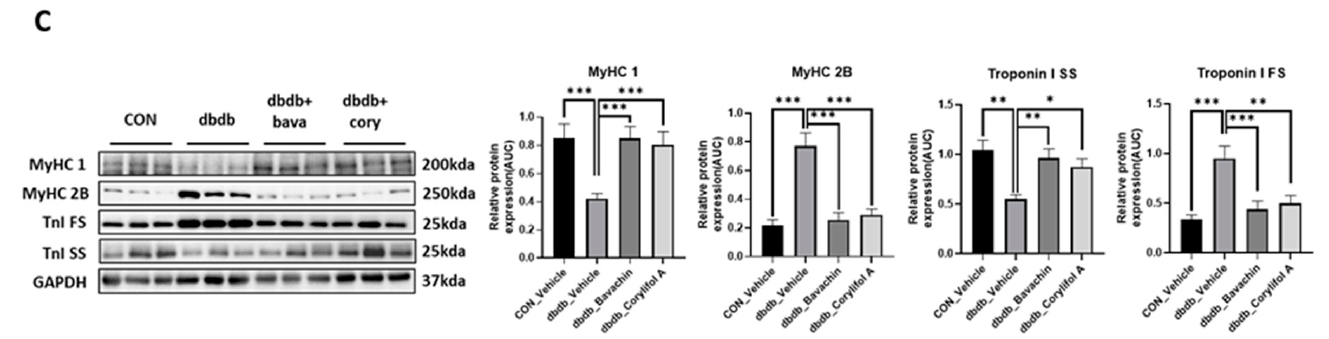
Figure 6. Bavachin and corylifol A induce the conversion of fast muscle fibers to slow muscle fibers in db/db mice. Twelve week old male db/db mice were administered bavachin (10 mg/kg) or corylifol A (10 mg/kg) for 40 d. ( A ) Representative images of MyHC immunofluorescence in GA muscle. Images were triple labeled for MyHC 1 (blue, type 1 fibers), MyHC 2A (green, type 2A fibers), and MyHC 2B (red, type 2B fibers). Scale bar indicates 50 µ m. Images were captured at 600 × magnification. ( B ) Proportion of MyHC isoform-specific fibers. Protein expression levels in the GA muscles were determined via western blotting. ( C ) Protein expression levels of MyHC 1, MyHC 2B, troponin I fast skeletal muscle (TnI-FS) and troponin I slow skeletal muscle (TnI-SS). All data are represented as the mean ± S.E.M., n = 6/group; * p < 0.05, ** p < 0.01, *** p < 0.001; nonparametric analysis of variance, followed by Kruskal-Wallis test.